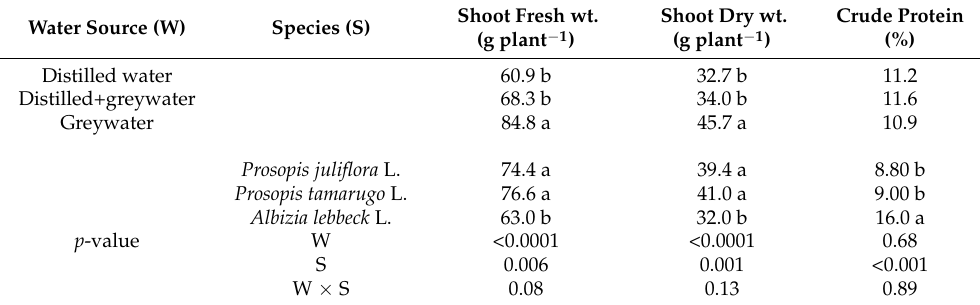
Shoot Fresh wt. Shoot Dry wt. Crude Protein (g plant − 1 ) (g plant − 1 ) (%)